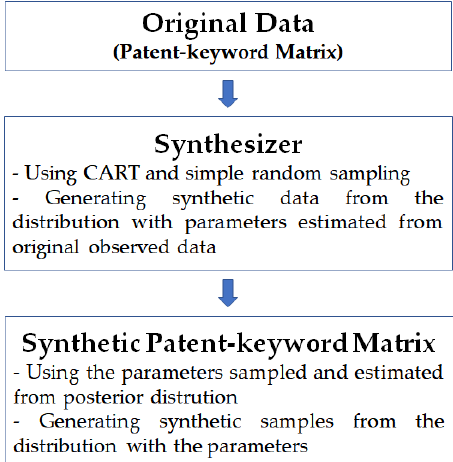
Figure 5. Generating synthetic samples from patent-keyword matrix.